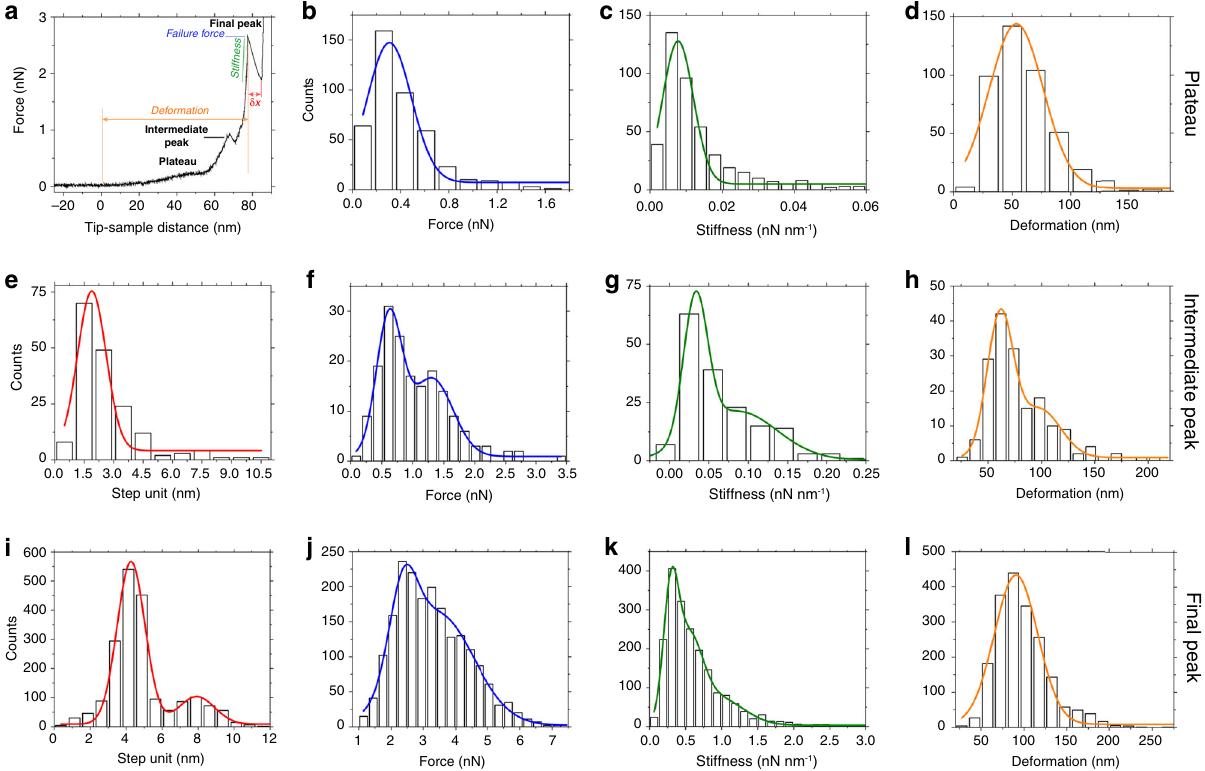
Fig. 2 Mechanical characteristics of lamin fi laments. a An FE curve showing a characteristic plateau and an intermediate peak preceding the fi nal peak at high force ( ≈ 3 nN). b The plateau occurred at a force of 0.30 ± 0.20 nN (average ± standard deviation calculated from FWHM). c The region showed a stiffness of 0.0078 ± 0.0043nN nm − 1 ( n = 432, n is the number of single events), and d a deformation of 54 ± 23 nm ( n = 432). e The step unit of the intermediate peak was 1.9 ± 0.7 nm at a force of 0.60 ± 0.20 nN ( n = 175) ( f ). g A stiffness of 0.033 ± 0.015 nN nm − 1 ( n = 172) was fi vefold more than that of the structural intermediate at the plateau. h A deformation of 61 ± 12 nm ( n = 173) was marginally larger than that at the plateau. The shoulders in the histograms, f force (1.3 ± 0.30 nN), g stiffness (0.086 ± 0.050 nN nm − 1 ), and h deformation (98 ± 20 nm) indicate a continuum of the stiffening process. i Step unit histograms (4.3 ± 0.80 nm; 7.9 ± 1.0 nm; n = 1946); j failure force (2.4 ± 0.40 nN; 3.5 ± 1.1 nN; n = 1946); k stiffness (0.30 ± 0.11 nN nm − 1 ; (Supplementary Fig.